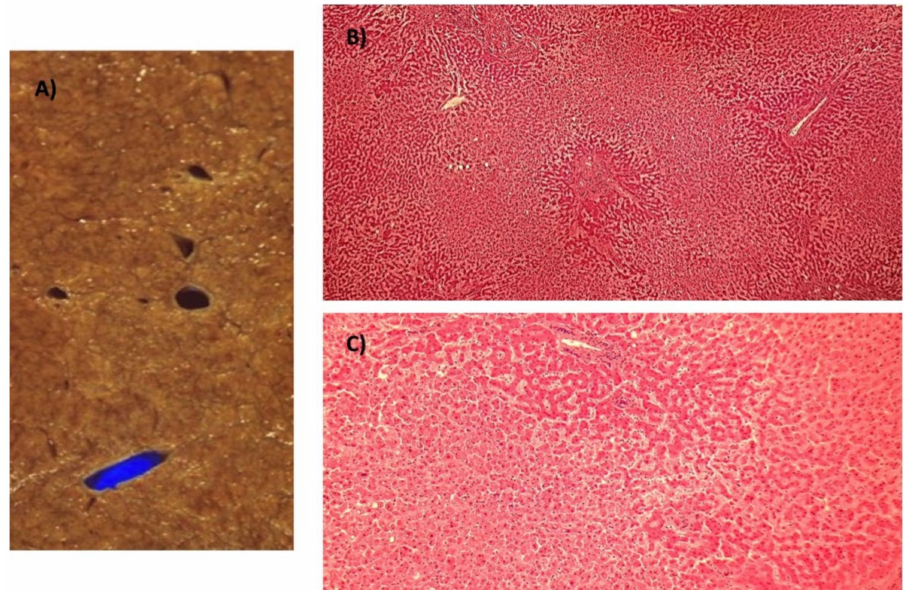
Figure 7. ( A ) Postmortem example of a liver with ischemic zones around centrilobular veins. ( B ) Centrilobular regions show congestion and coagulative necrosis (hematoxylin-eosin stain, 4 × objective). ( C ) Same findings as 7B, with greater magnification (10 ×